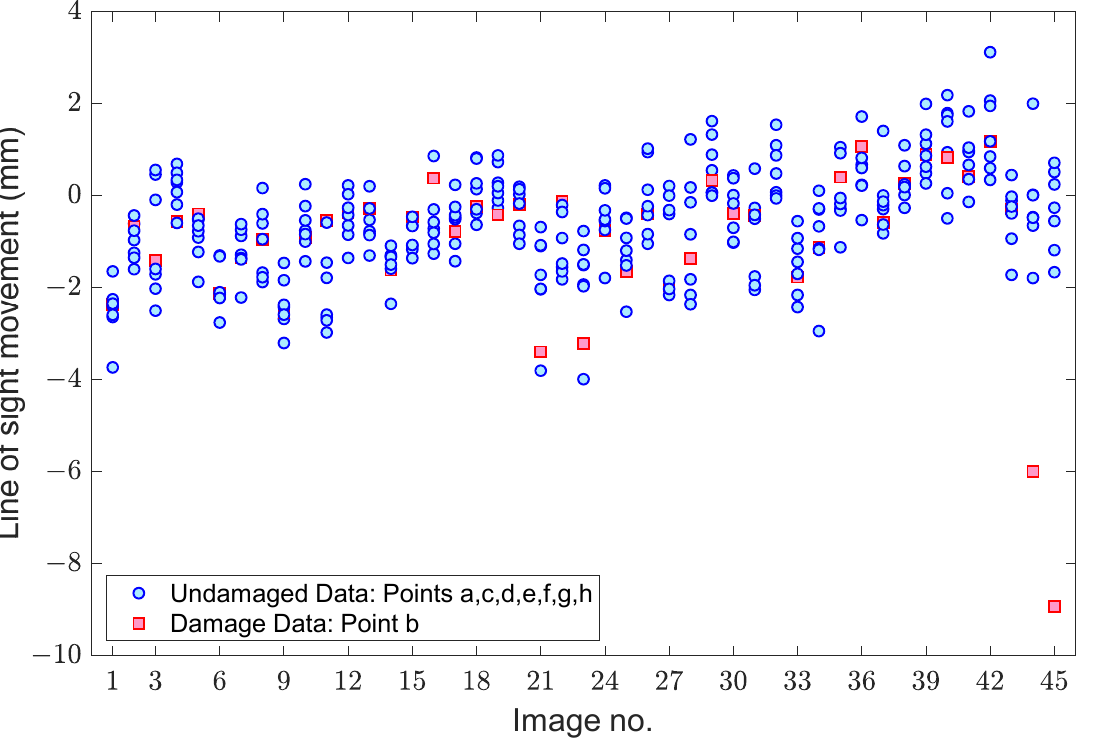
Figure 6. Displacement samples of the eight points regarding the undamaged and damaged areas [34] .